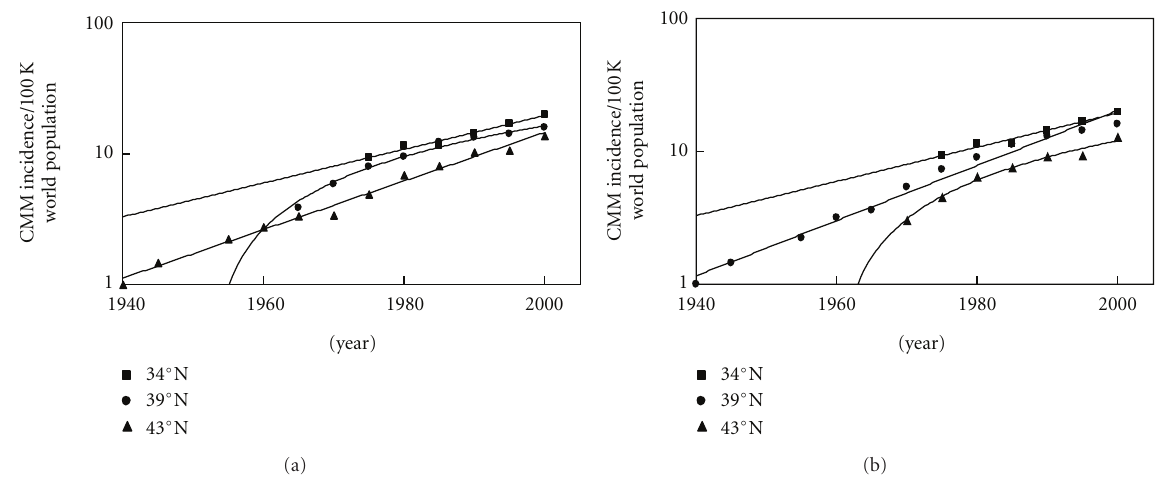
Figure 3: (a) The data indicates an increasing incidence of CMM in the white population of the USA for six decades at three latitudes: ∼ 34 ◦ N (average of Los Angeles, California; Atlanta, Georgia; New Mexico), 39 ◦ N (average of San Francisco, California, and Utah) and 43 ◦ N (average of Iowa, Michigan, Connecticut, and Upstate New York). The CMM incidences at 34 ◦ N and 43 ◦ N are increasing at exponential rates while at 39 ◦ N, it is increasing at a linear rate (determined by comparing R 2 values for the linear and exponential trend lines). (b) The CMM incidence data at 39 ◦ N changes from linear to exponential and the 43 ◦ N data changes from exponential to linear when Connecticut is averaged with San Francisco and